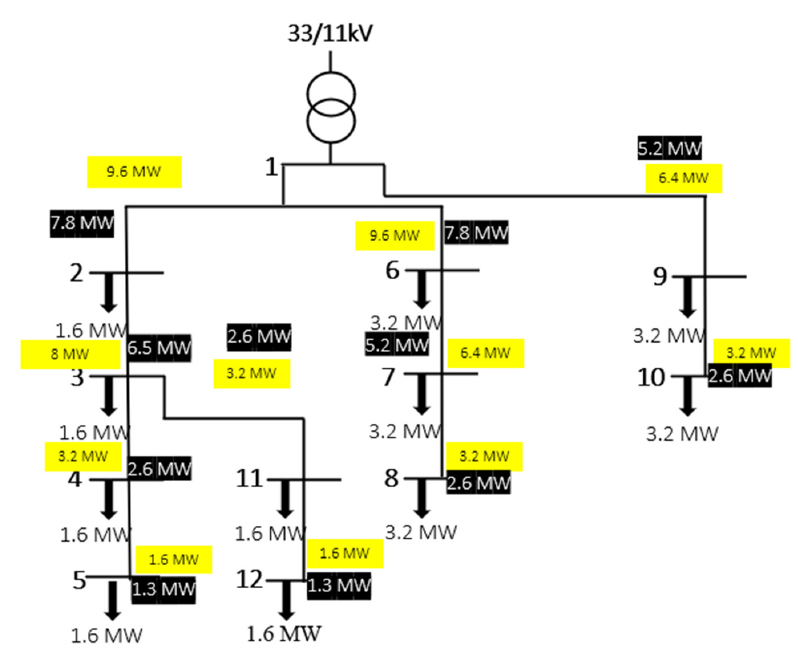
Figure 7. Schematic diagram of the HV electricity grid showing the initial line thermal limits (in black), and the second-stage peak load (downward black arrows) assuming that in the second stage scenario S 1 has occurred (i.e., 100% load growth at every bus) and that EV smart charging, with flexibility = 40%, has been deployed for all EVs in the system i.e., at every bus in the system. Moreover, the second stage power flows are shown (in yellow) ignoring thermal line limits.